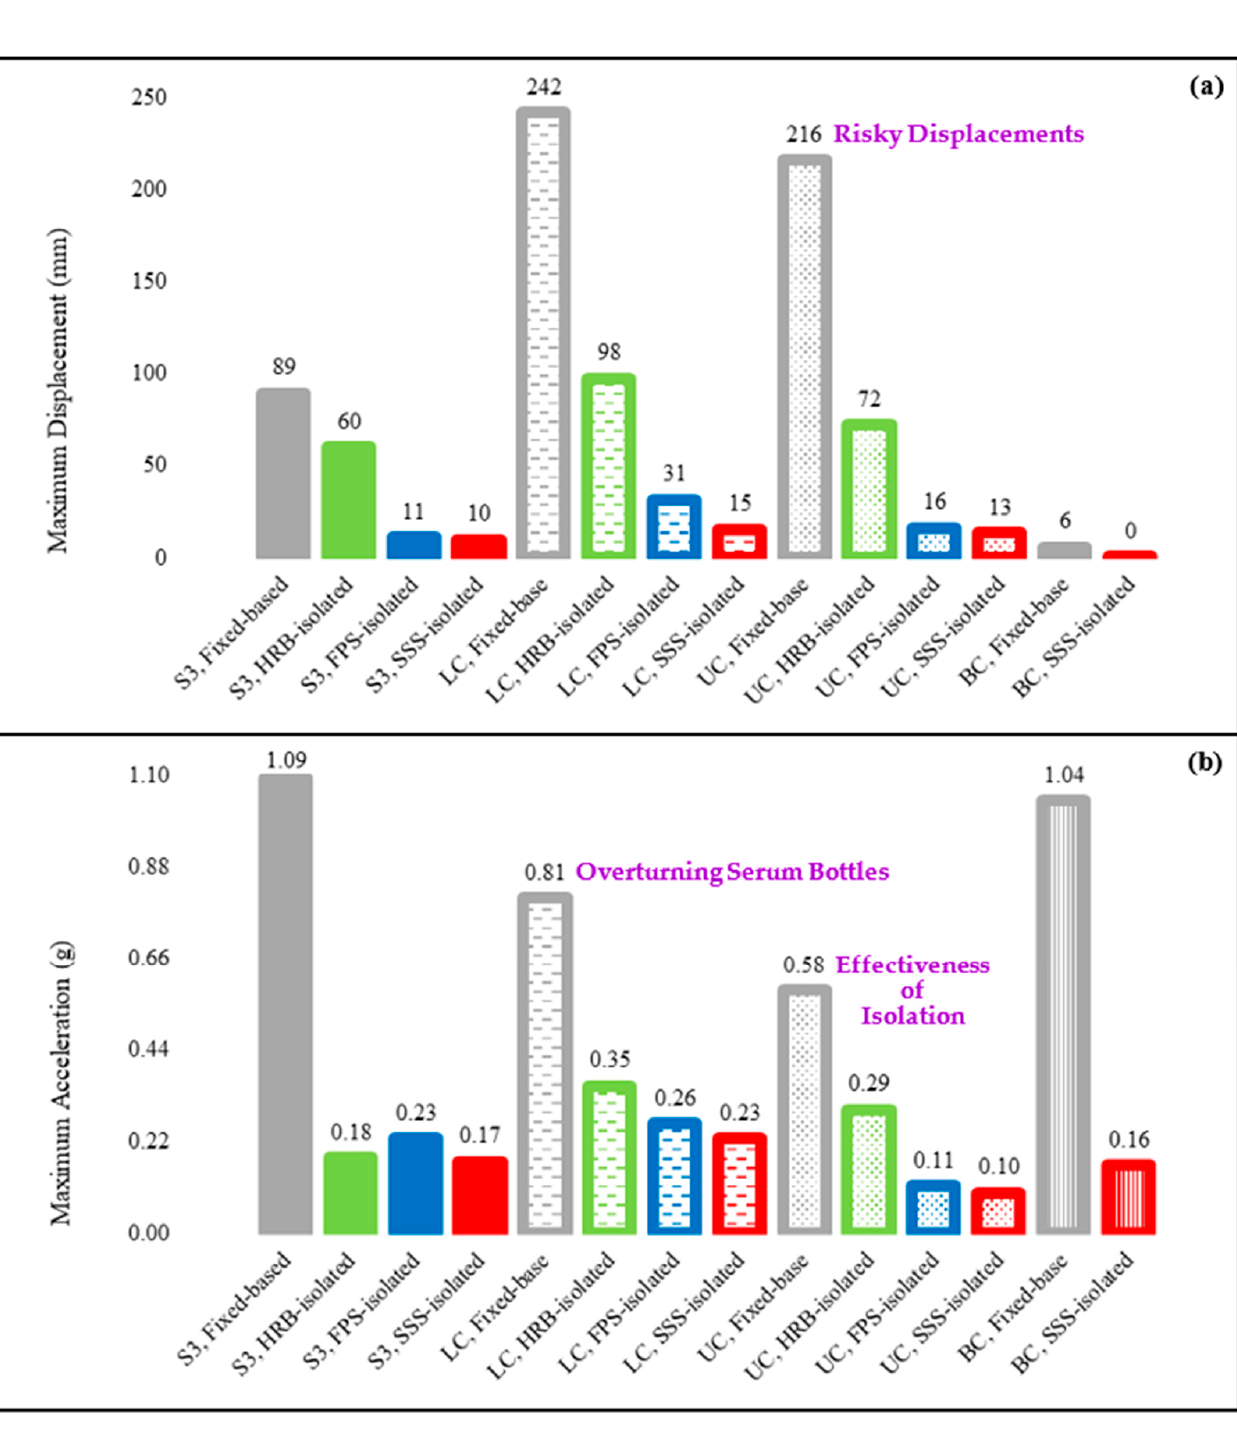
Figure 12. Maximum ( a ) displacements and ( b ) accelerations of the ground motion GM4 (used to generate the input excitations for the shaking table tests), the third story (S3) of the hospital building in all the fixed-base and base-isolated (HRB, FPS, and SSS-isolated) cases subjected to GM4, and the cart in all the locked (LC), unlocked (UC), and braced (BC) conditions in the fixed-base and base-isolated cases.